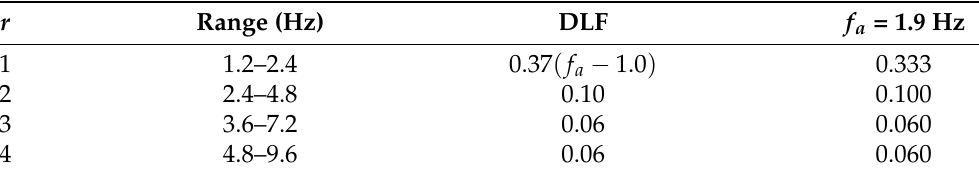
Table 7. Vertical MF model of a single pedestrian walking according to ISO-10137 [15].